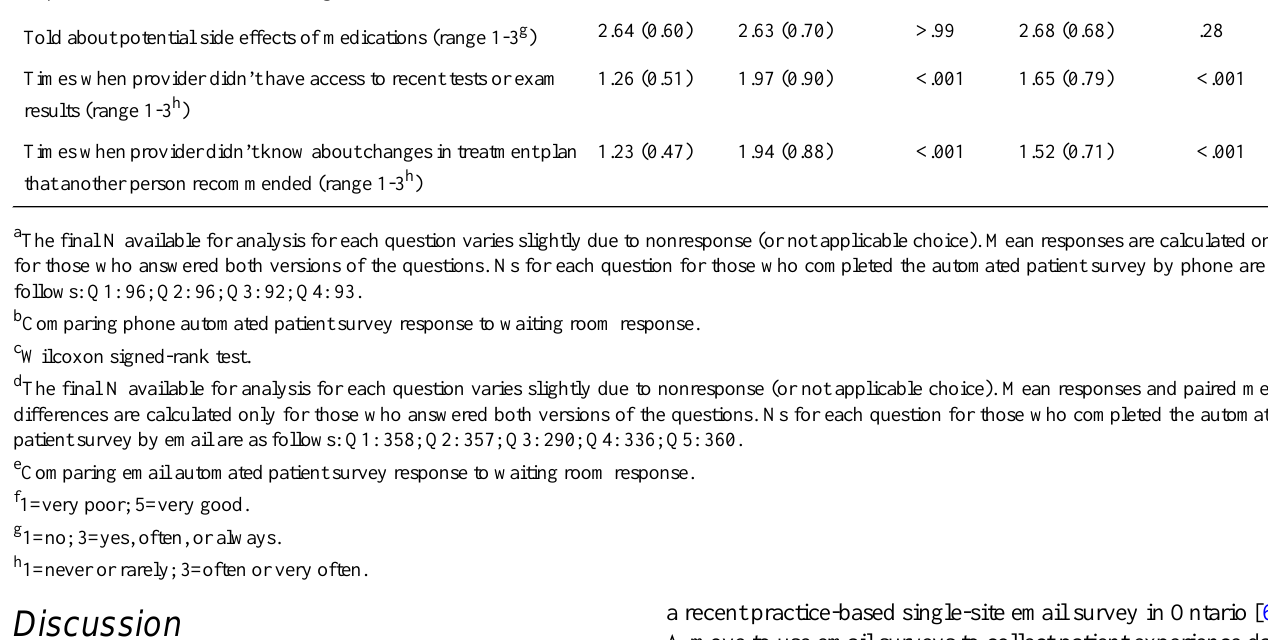
Automated patient survey response—by modeWaiting room response,